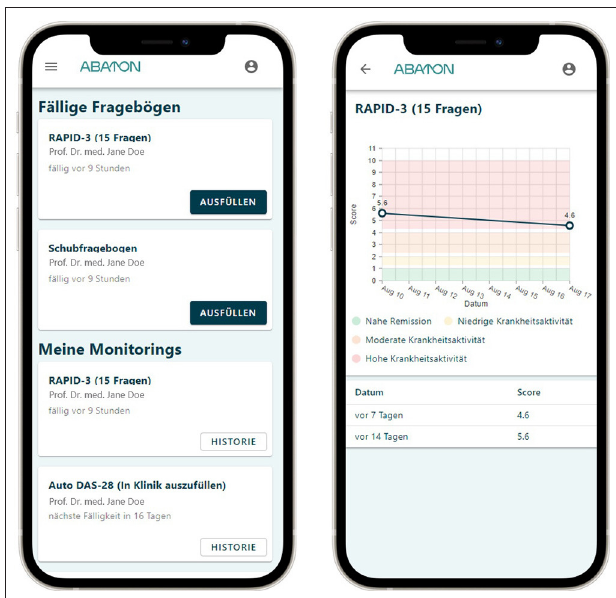
FIGURE 4 | ABATON patient app screenshots, displaying questionnaire overview on the left and graphical display of RAPID-3 history on the right. RAPID 3 routine assessment of patient index data-3. Translations: Ausfüllen, Fill in; Datum, date; Fällige Fragebögen, due questionnaires; Fragen, questions; Historie, history; Hohe Krankheitsaktivität, high disease activity; In Klinik auszufüllen, to be answered in the outpatient clinic; Meine Monitorings, my monitorings; Moderate Krankheitsaktivität, moderate disease activity; Nahe Remission, close remission; Niedrige Krankheitsaktivität, low disease